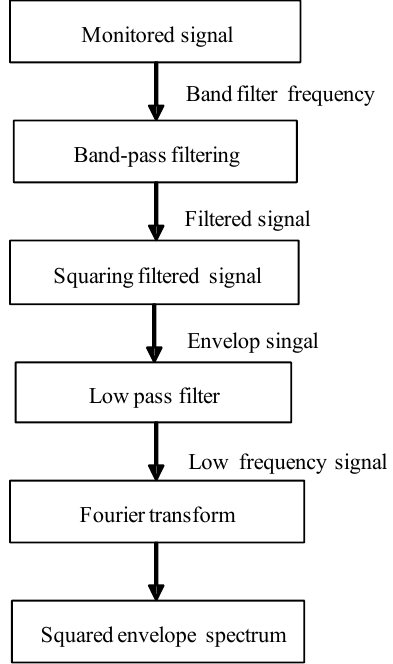
Figure 3. Flowchart of squared envelope spectrum